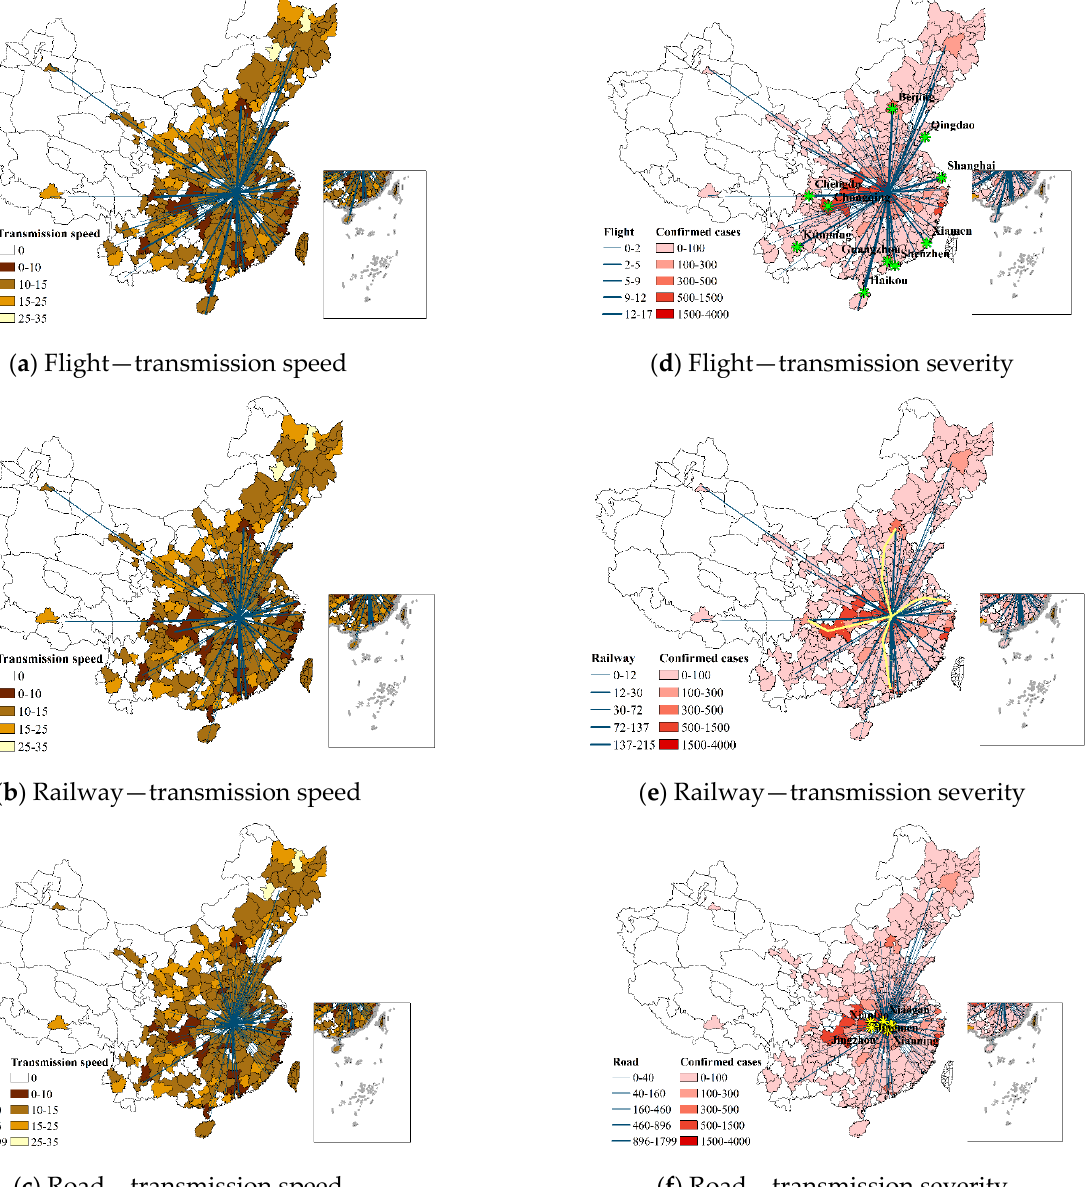
Figure 2. Correlation between different transportation modes and transmission patterns.